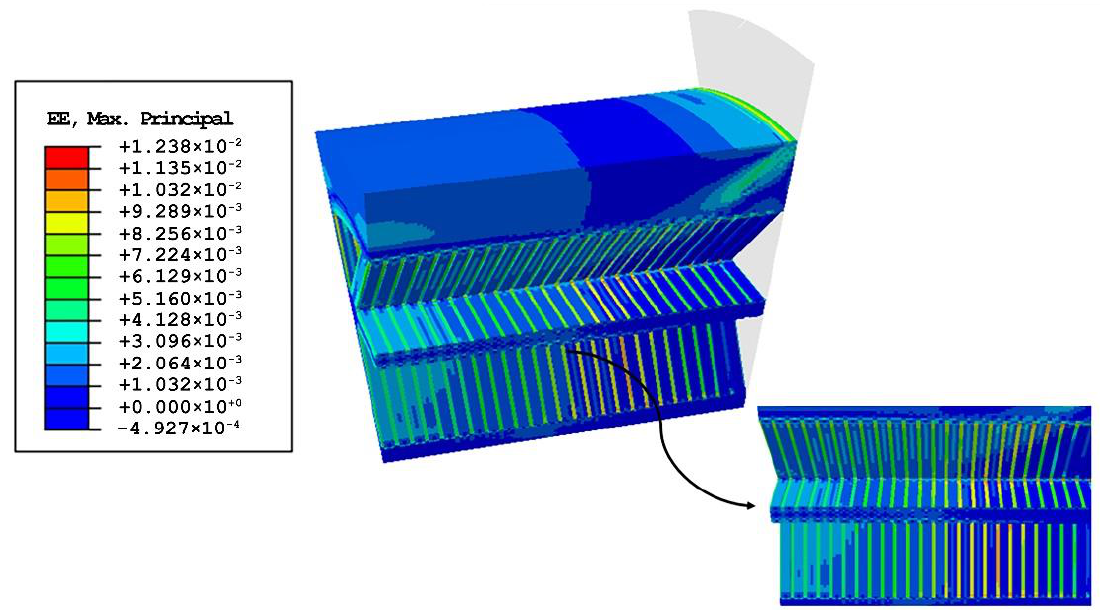
Figure 18. Elastic strain contour at the end of loading – unloading.